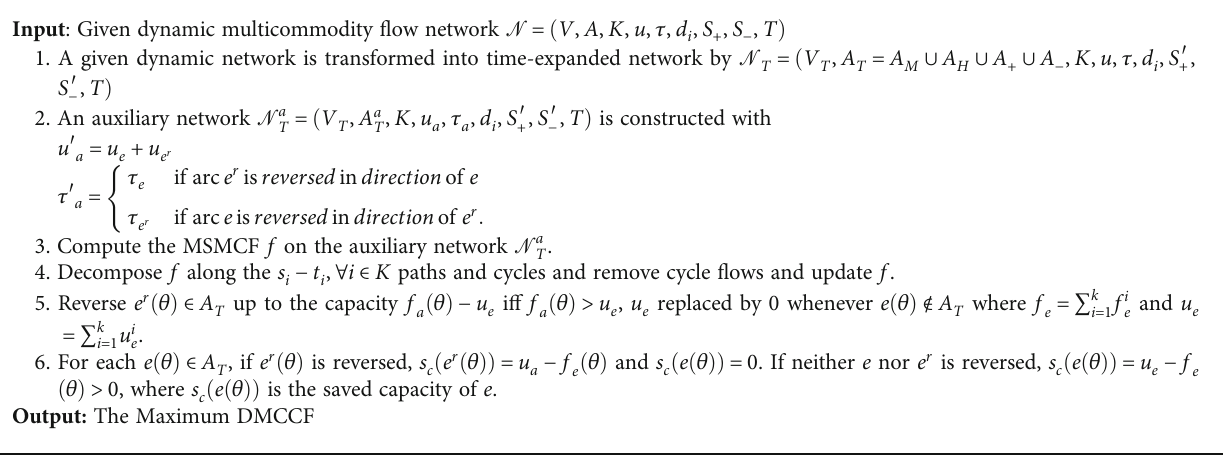
Algorithm 1:Algorithm for maximum